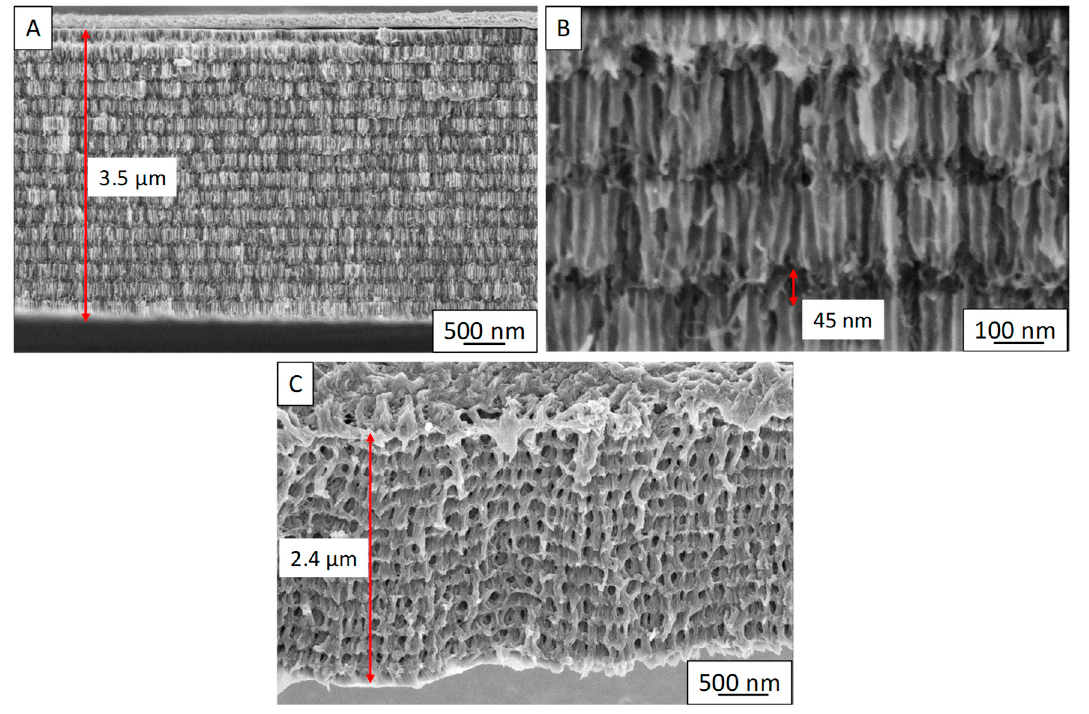
Figure 6. ( A ) FE ‐ SEM of 3D PEDOT nanostructures inside AAO, ( B ) detail of the FE ‐ SEM images of the transversal channels of the 3D PEDOT nanostructures inside AAO, and ( C ) freestanding 3D PEDOT nanostructures where the air gaps are controlled inside the PEDOT film.